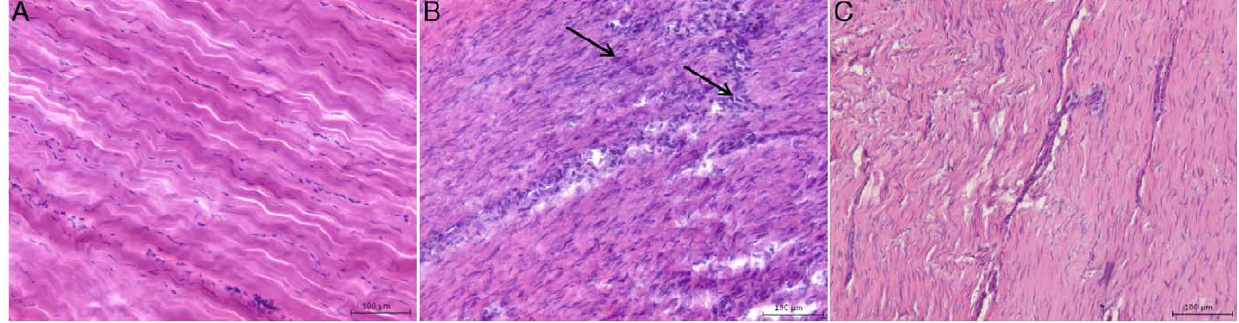
Figure 1. Typical microscopic appearance of normal and injured equine flexor tendons. Longitudinal histology sections stained with Haematoxylin and Eosin showing: (A) normal superficial digital flexor tendon (SDFT) from a 6 year old horse showing regular arrangement of parallel collagen fibrils. Scale bar=100 m m. (B) Sub-acutely injured SDFT 3 weeks post injury from a 4 year old horse showing marked cellular infiltration (black arrows). Scale bar=100 m m. (C) Chronic injured SDFT . 3 months post injury from a 12 year old horse showing increased cellularity and poor organisation of collagen fibrils compared to (A). Scale bar=100 m m.